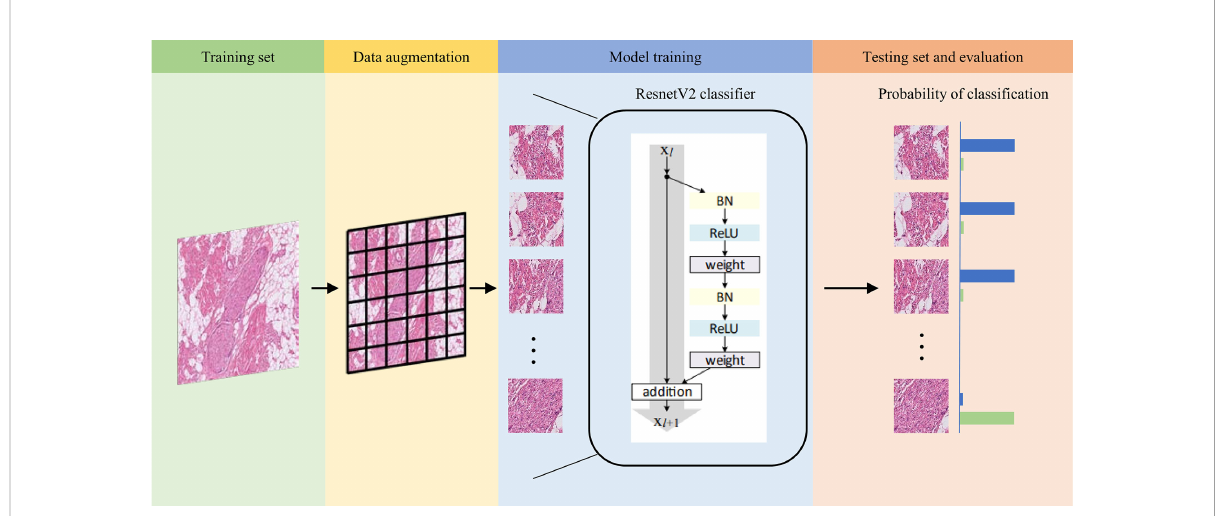
FIGURE 3 Work fl ow used for training and testing the ResnetV2_50 reference model. Images in the training set (green background) were split into smaller patches for data augmentation (yellow background) and subsequently trained with the ResnetV2 model (blue background). When the model converged to a good training accuracy, test results were calculated (orange background). The trained model was fi nally applied to analyze patches and assign a probability of normal nerve fi bers (blue bar) and perineural invasion (green bar). When the probability of normal nerve fi bers was higher than that of perineural invasion, the image was labeled as normal nerve (and vice